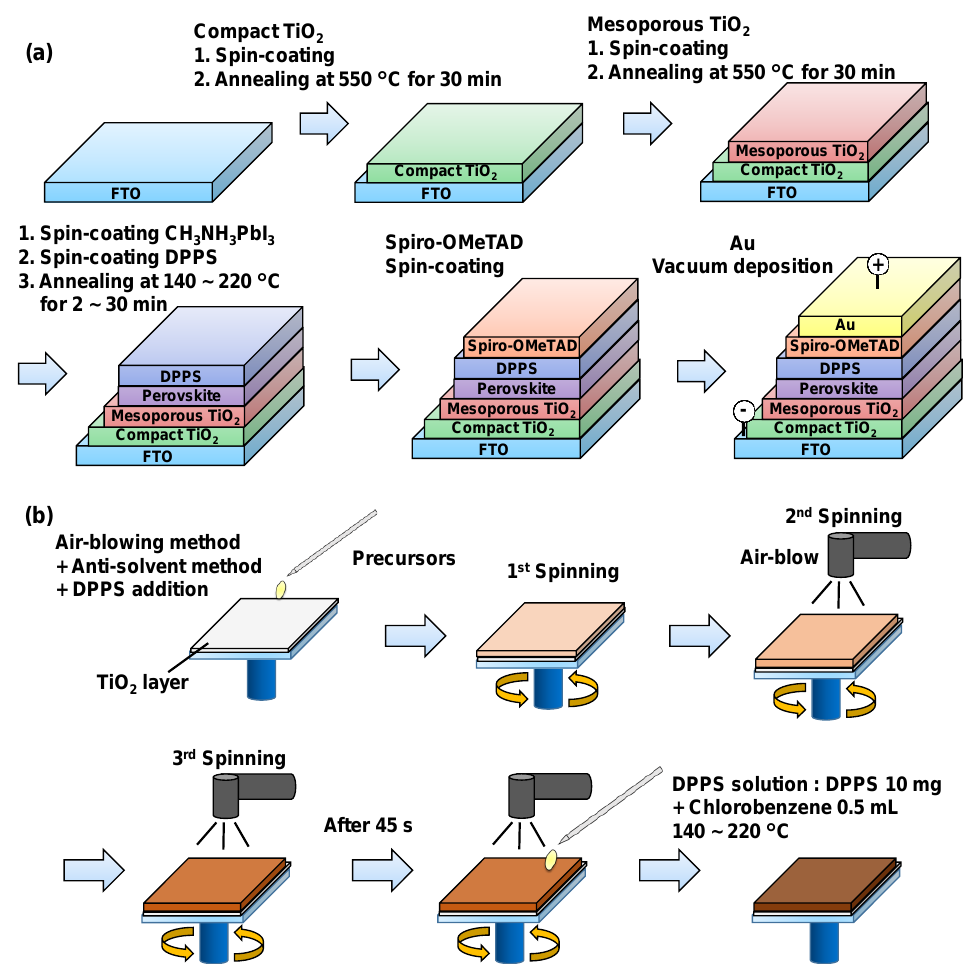
Figure 1. ( a ) Schematic illustration of the fabrication process of the perovskite photovoltaic devices. ( b ) Detailed illustration of DPPS insertion process.